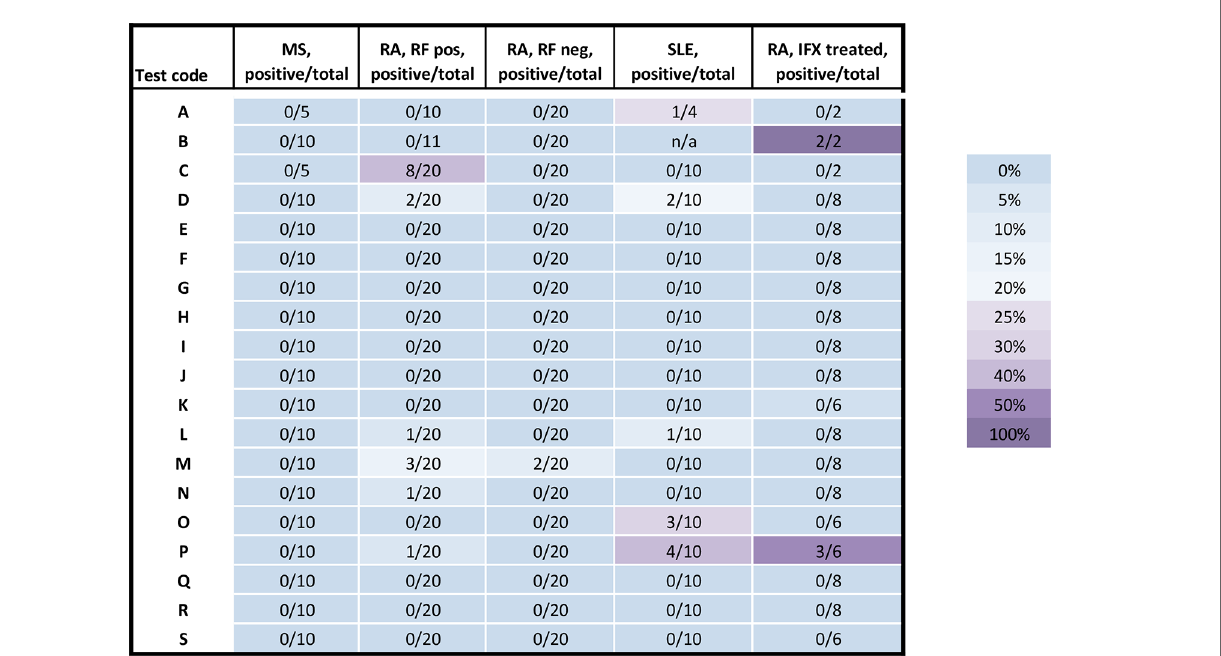
FIGURE 3 | Percentage of the false positive test results for IgG. Samples from MS patients (n=10), DMARD naïve RF positive RA patients (n= 20), RF negative (n=20) RA patients, SLE patients (n=10), in fl iximab treated RA patients (n=8). The test code keys are described in Table 2 . Pos, positive; neg, negative; n, number; RF, rheumatoid factor; IFX, in fl iximab; n/a, not applicable; RA, rheumatoid arthritis; MS, multiple sclerosis; SLE, systemic lupus